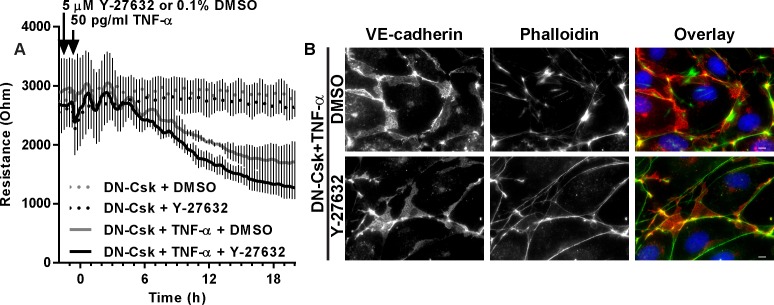
Blockade of actin stress fiber formation by ROCK inhibition does not prevent LD-TNF/DN-Csk-induced loss of barrier function.Cells were seeded at confluence and incubated for 72 hours. Then, growth media was replaced by low serum media and cells were infected with adenovirus to express either LacZ (control) or DN-Csk. After another 16 h, cells were pretreated with DMSO (vehicle) or Y-27632 (ROCK inhibitor) for 30 minutes prior to TNF-α addition. A, TEER measurements on ECIS electrodes. Notice the lack of effect of Y-27632 treatment on the loss of TEER in LD-TNF/DN-Csk cells. Data presented as mean±SEM. B, Cells were fixed 24 h after TNF-α treatment and IF was performed to detect VE-cadherin and F-actin (phalloidin). Nuclei were counterstained with DAPI. Notice that the formation of actin bundles that can be observed in DMSO-treated cells is absent in Y-27632-treated cells. Results are representative of at least three independent experiments performed in duplicate. Bar graph (mean±SEM) and statistical analysis of TEER for the 20 h time point corresponding to A is shown in S6E Fig.